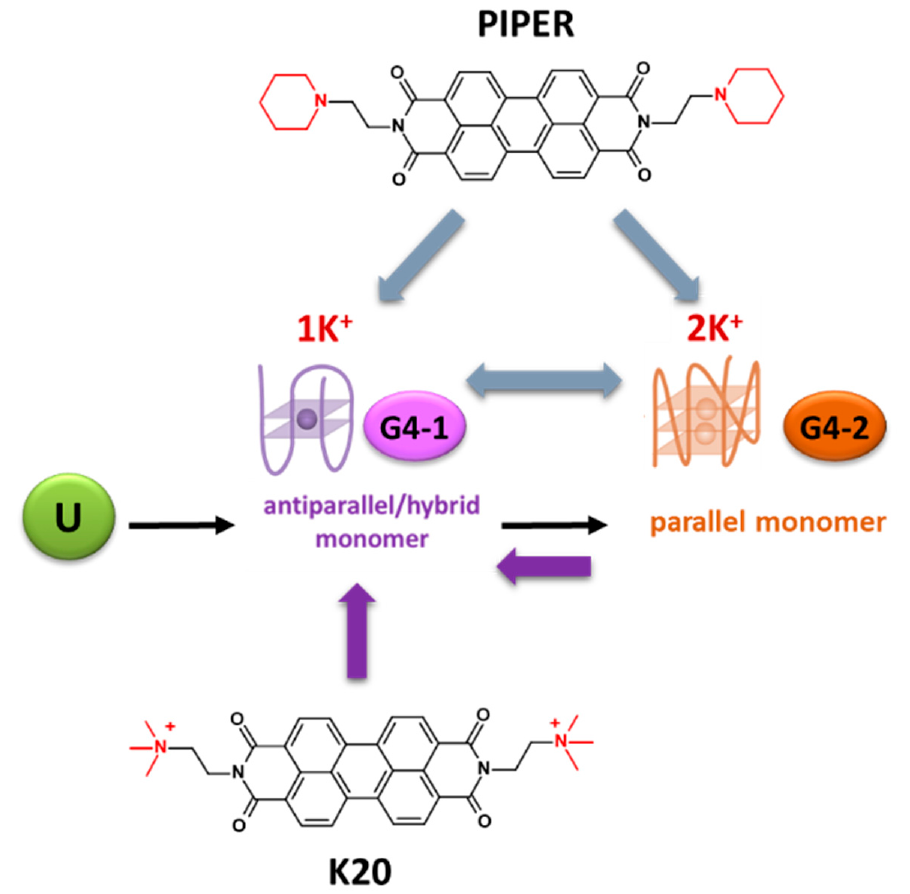
Figure 4. The two G4 states of kit2. 1K + and 2K + refer to the number of K + ions bound to the folded G4. U refers to the unfolded (or pre-folded) state, and G1 and G2 to the kinetically favored and the structurally solved monomeric G-quadruplex, respectively.